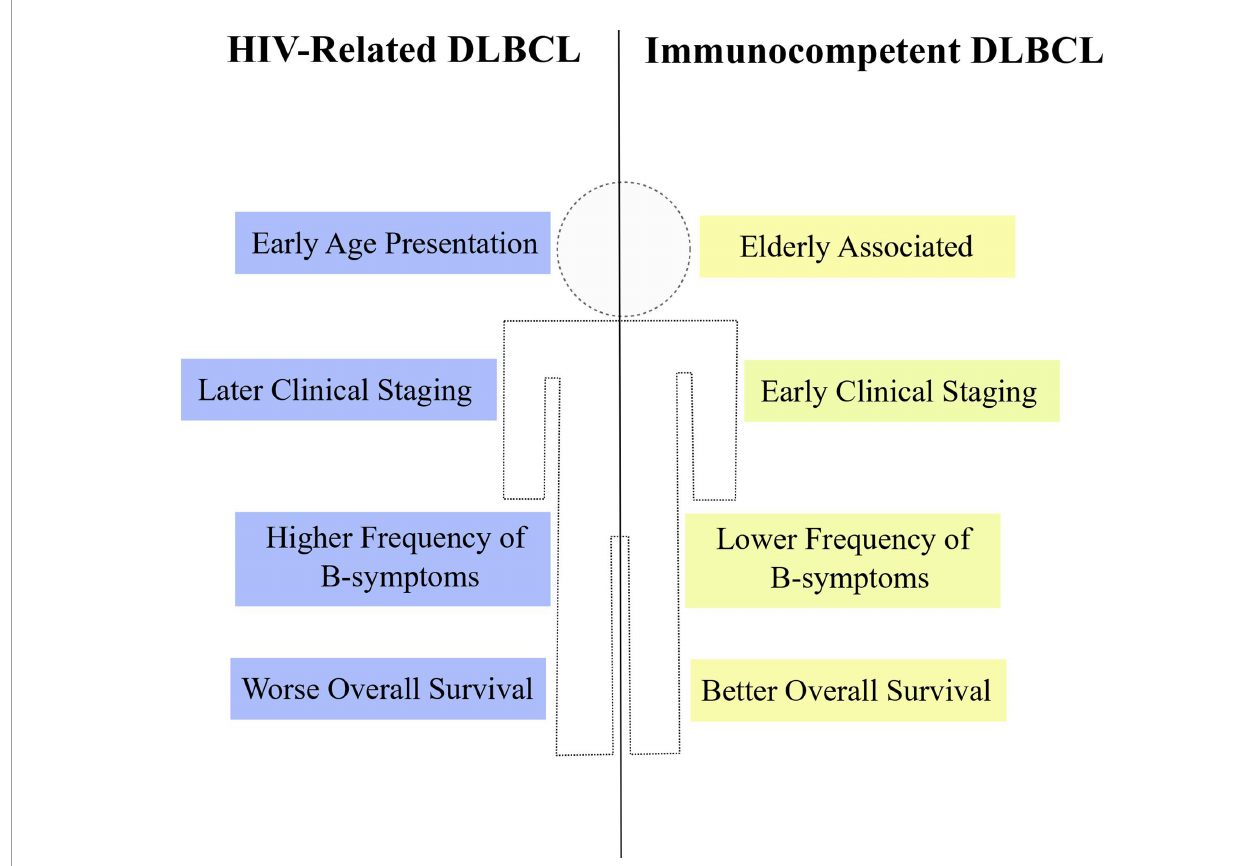
FIGURE 3 | Clinical properties of HIV-DLBCL. HIV-related DLBCL (blue) is commonly associated with particular clinical features when compared to immunocompetent DLBCL (yellow), such as early age at diagnosis, later clinical staging, higher frequency of B-symptoms and worse overall survival